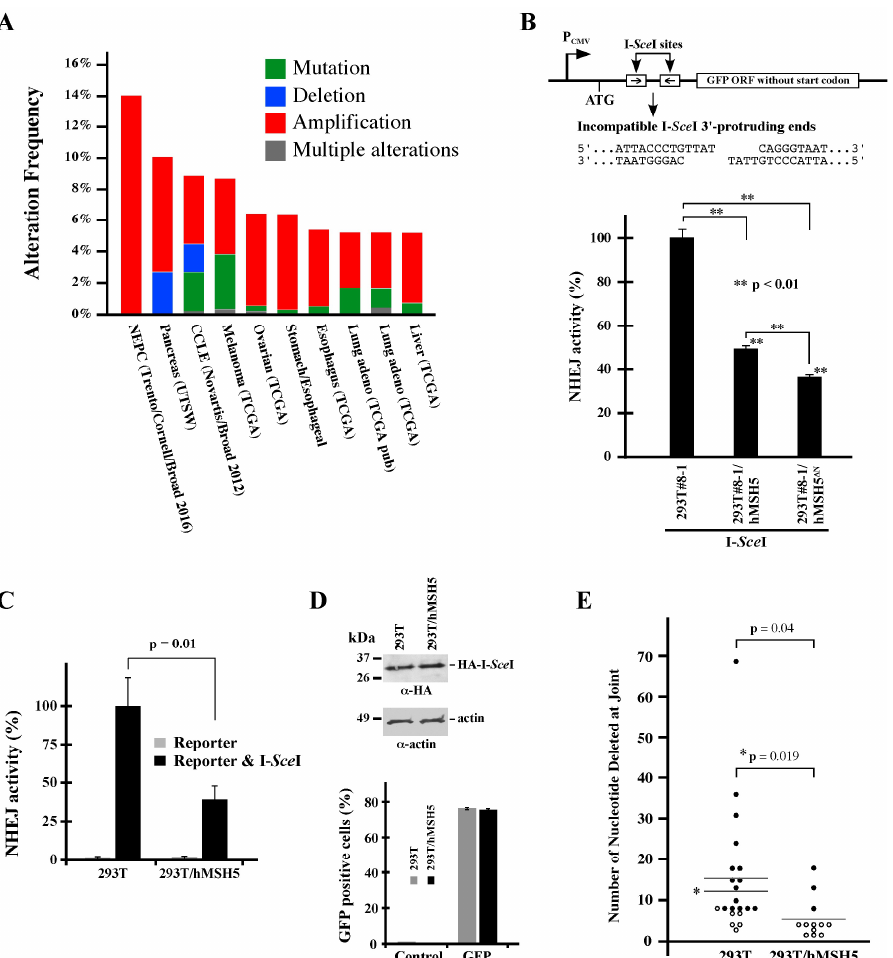
Figure 1. hMSH5 suppresses NHEJ-mediated DSB repair. ( A ) Analysis of the hMSH5 gene alteration in cancers. Data were retrieved from cBioPortal for Cancer Genomics (www.cbioportal.org). The stacked column graphs summarize 10 TCGA studies, of which each study has a sample size greater than 100, with at least 5% of the sample showing hMSH5 gene alterations. NEPC, neuroendocrine prostate cancer; CCLE, cancer cell line encyclopedia. ( B ) Schematic illustration of the NHEJ reporter locus in reporter cell line 293T/#8-1 [49]. NHEJ reporter analysis of the effect of hMSH5 ∆ N (hMSH5 aa116-834) (Tompkins et al., 2009). The cell lines used in this test were 293T/#8-1 derivatives stably expressing hMSH5 or hMSH5 ∆ N. ( C ) Analysis of the effect of hMSH5 on episomal NHEJ. 293T and 293T/hMSH5 cells were transiently transfected with either the NHEJ reporter construct alone or together with I- Sce I. ( D ) Levels of I- Sce I expression in 293T and 293T/hMSH5 cells determined by immunoblotting. The transfection efficiencies of 293T and 293T/hMSH5 cells (76% and 75%, respectively) were determined by transient transfection of pEGFP-C1, while untransfected cells were used as controls. ( E ) Sequence analysis of DSB repair junctions. The NHEJ reporter plasmid, together with I- Sce I construct, was transfected into 293T and 293T/hMSH5 cells. After inducing NHEJ-mediated end-joining at the reporter locus, repair joints were recovered by PCR amplification from total DNA. Cloned PCR products were sequenced. Sequencing data were analyzed by Tatsuki’s Dot Plot to reveal nucleotide deletions at the repair junctions. Solid circles signify repair joints without any I- Sce I 3 (cid:48) -protruding nucleotides ( B , top ), whereas open circles denote the inclusion of at least one of the 3 (cid:48) -protruding nucleotides at the repair junctions. Asterisks denote a similar statistical analysis in which the outlier (deletion of 69 nts) was omitted. Error bars represent standard deviations from the means of three replicates. Statistical significance was assessed by Student’s two-tailed t